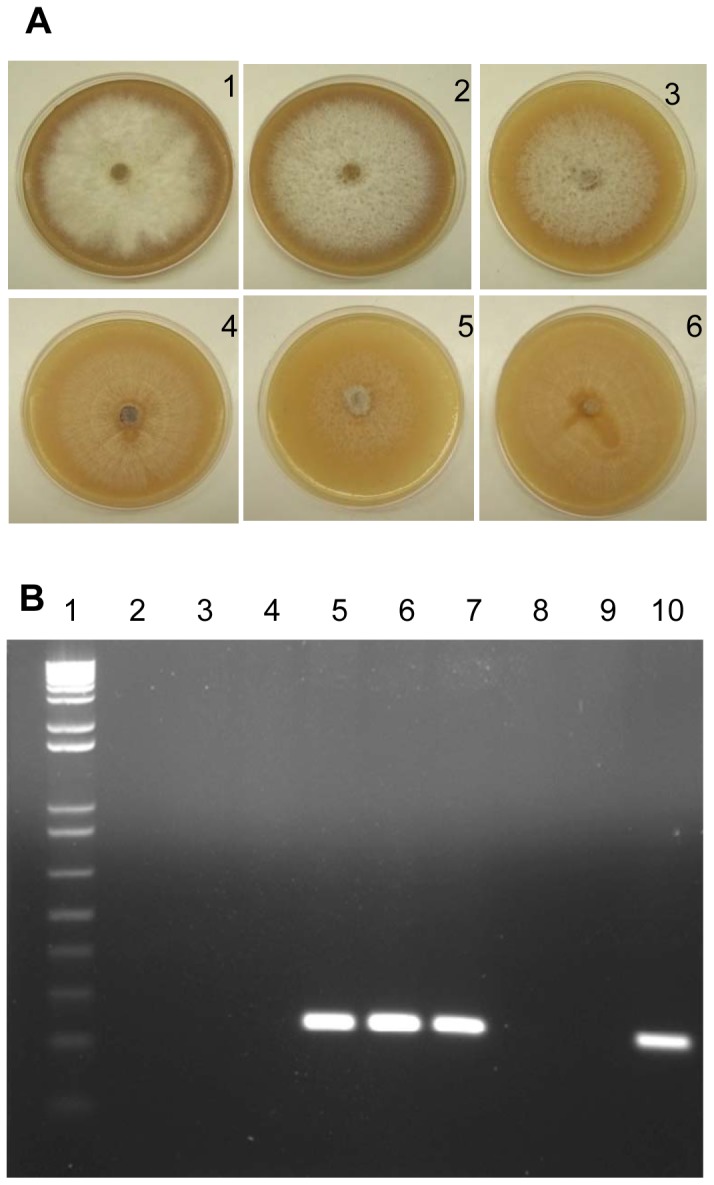
Primer Specificity of SIX1 for Fusarium oxysporum f. sp. lycopersici (Fol) strains.(A) Fusarium strains were point inoculated with an agar plug (0.5 cm in diameter) on V8 agar medium and incubated for 8 days at 25°C under 14 h light/10 h dark cycle. 1–4: Fol strains; 5: F. oxysporum f. sp. vasinfectum; 6: F. oxysporum. (B) PCR analyses for Fol primers specificity. Lanes: 1, DNA marker; 2, water; 3, F. verticillioides; 4, F. graminearum; 5,6,7,10, Fol isolates; 8, F. oxysporum f. sp. vasinfectum; 9, F. oxysporum.